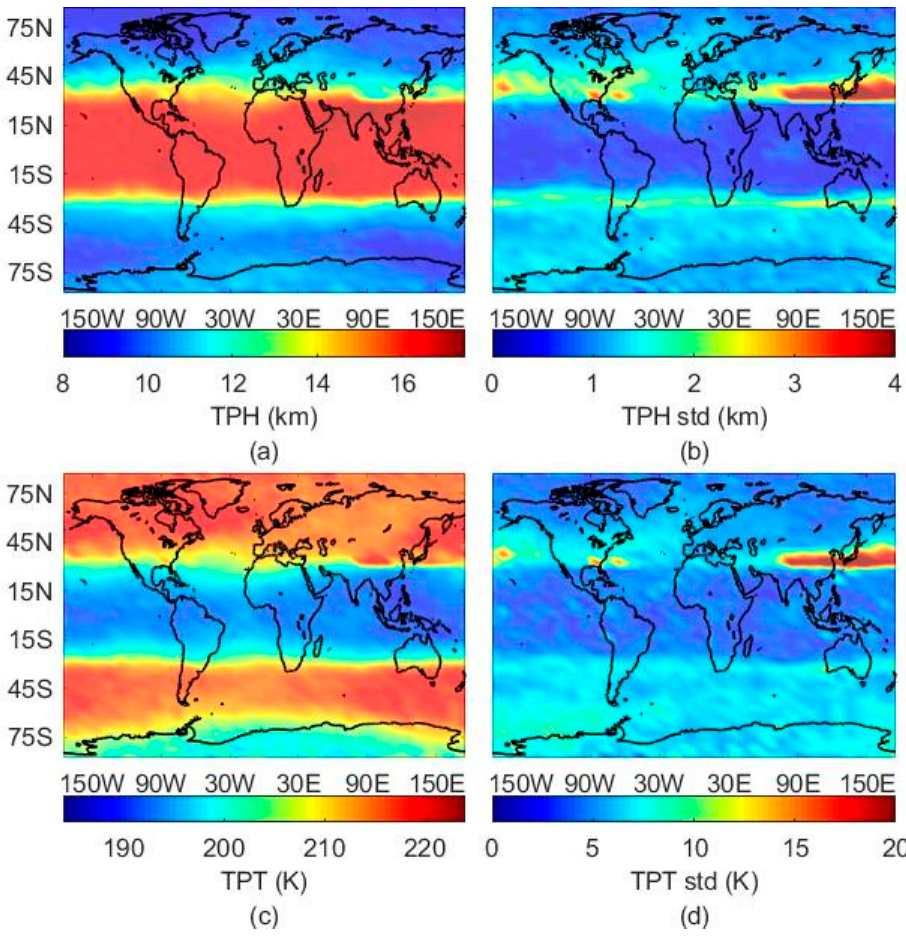
Figure 12. Seasonal patterns (a–d) of TPT and TPH for autumn (September, October, November).